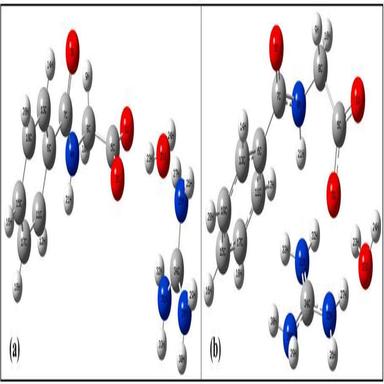
(a) Structure of GuHM from SC-XRD (b) DFT optimized geometry of GuHM.